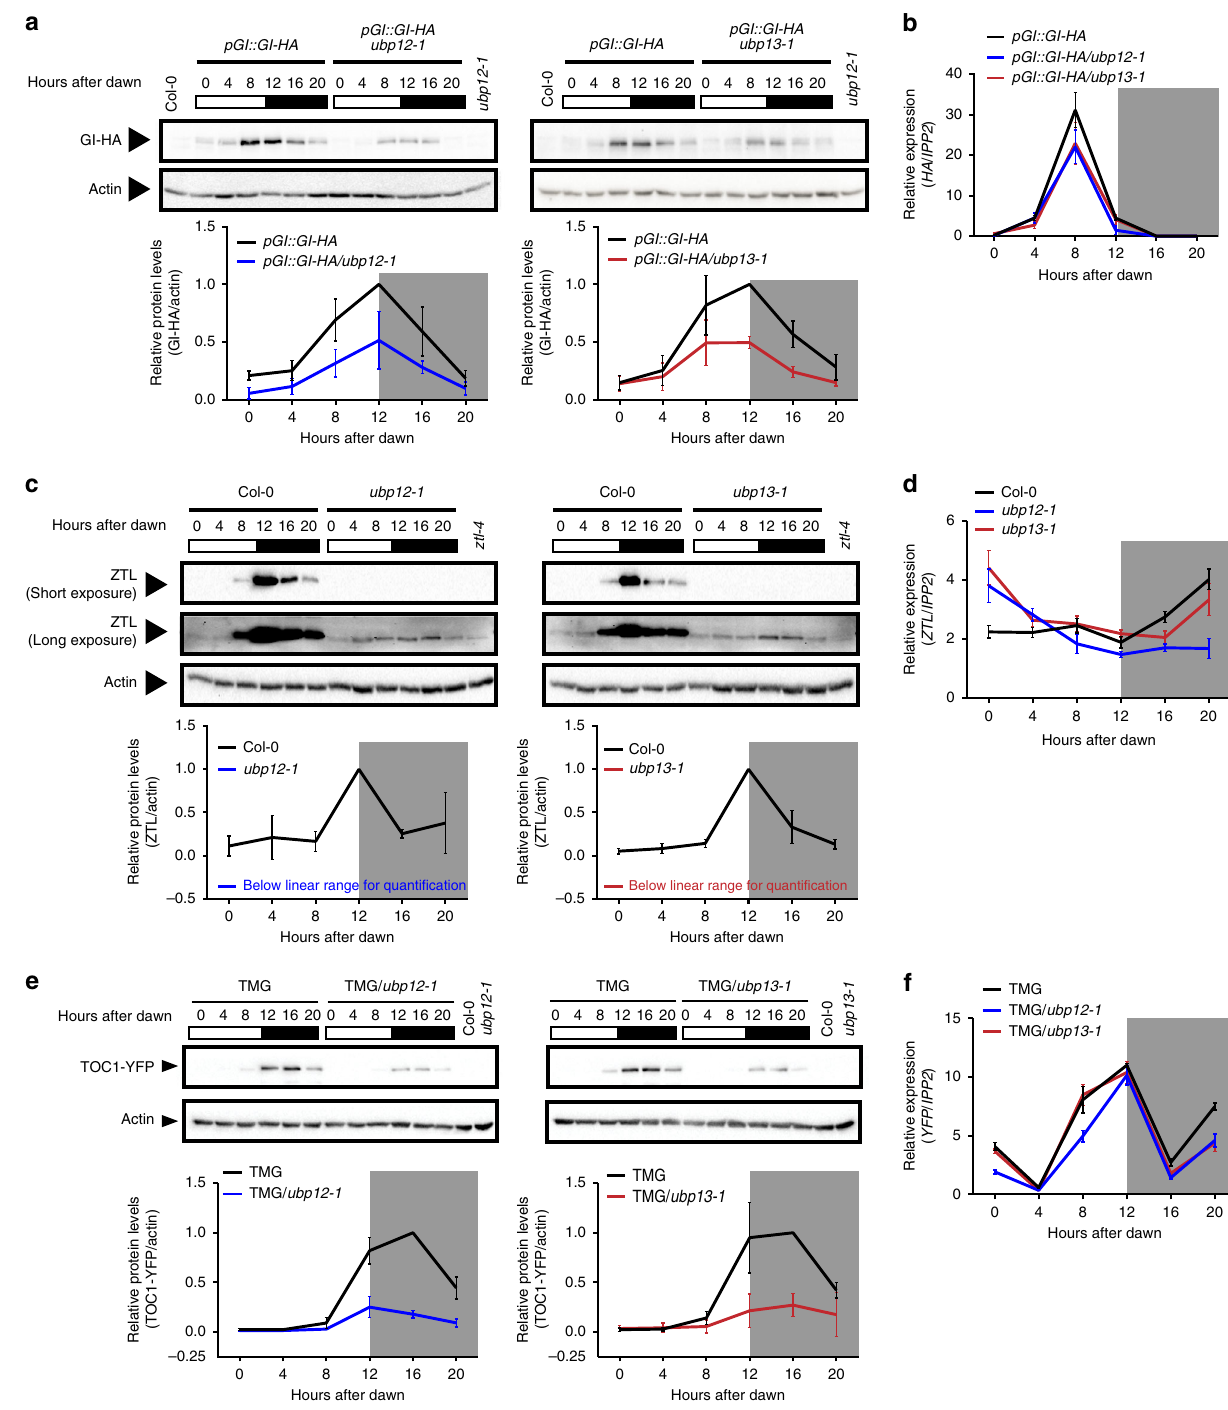
Fig. 3 ZTL, GI, and TOC1 protein levels are regulated by UBP12 and UBP13. a , c , e The protein levels of HA-tagged GI driven by native promoter ( pGI::GI- HA ), ZTL and YFP-tagged TOC1 driven by the TOC1 promoter (TOC1 minigene or TMG) in the wild type (Col-0), ubp12-1 , or ubp13-1 mutants under diurnal conditions (12 h light/12 h dark) were detected by immunoblotting. The samples from 0 h to 12 h after dawn were harvested in light, and the samples from 16 h and 20 h after dawn were harvested in the dark (indicated by gray shading). The relative protein levels were quanti fi ed by normalization to actin. The Col-0 or ztl-4 samples were used as negative controls for the antibodies. Plots represent the average protein levels from three biological replicates, and the error bars represent standard deviation. Compared to wild type, the levels of ZTL proteins in the ubp12-1 and ubp13-1 were below the linear range for quanti fi cation. In the ztl-4 sample, the anti-ZTL antibody recognizes a non-speci fi c band close to the size of endogenous ZTL in the long-exposure blots. b , d , f The relative mRNA levels of GI-HA , ZTL , or TOC1-YFP from the same time course samples were measured by qRT-PCR. The source data are provided as a Source Data fi le. Blot images were cropped from their original size, which can be found in Source Data fi